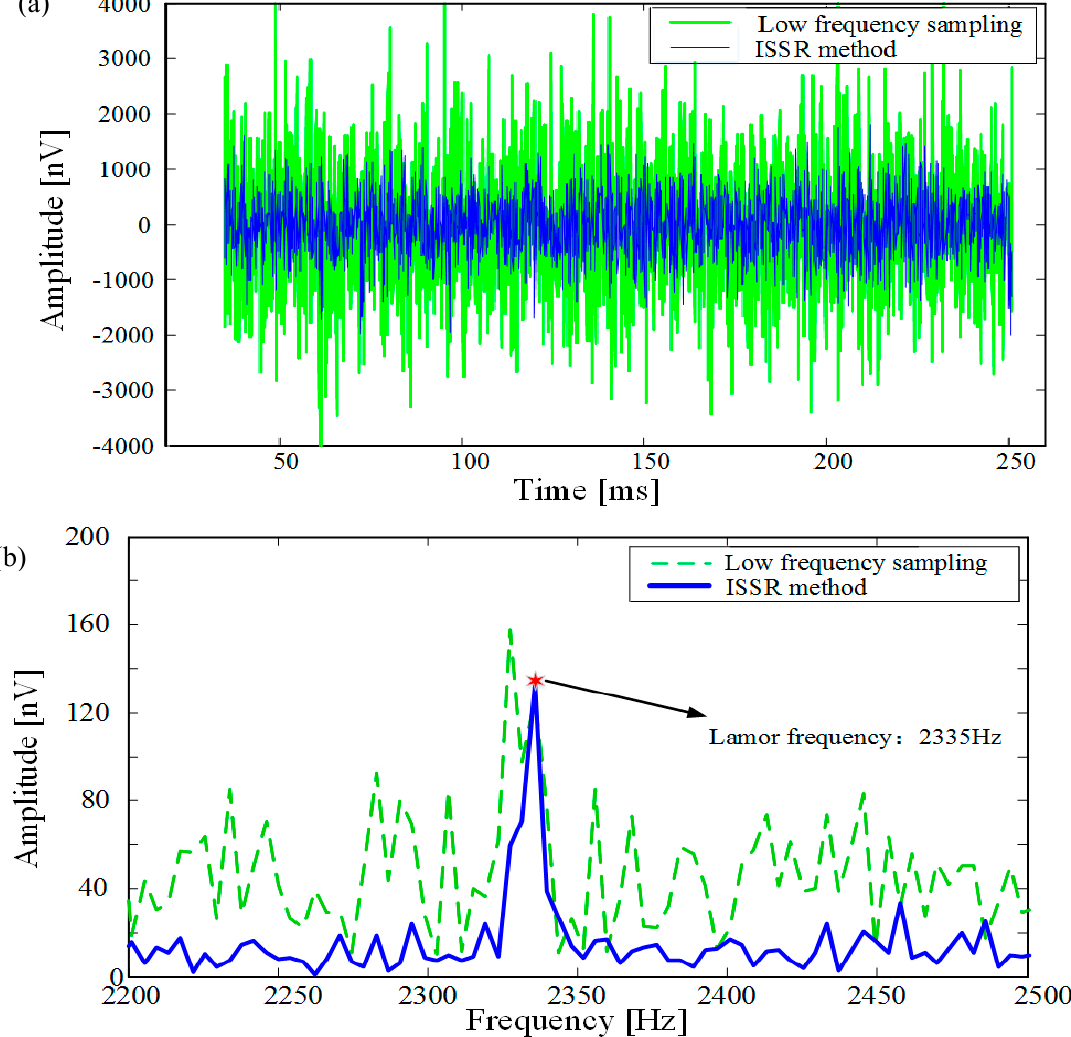
Figure 16. Comparison of low frequency sampling result and the ISSR method results. The green lines display low frequency sampling recording (its sampling frequency is 8330 Hz) and the standard deviation is 1200.80 nV. The blue lines display the data by the ISSR method (its sampling frequency is 50 kHz, f prop = 8333.3 Hz) and the standard deviation is 570.01 nV. ( a ) Comparison in time domain. ( b ) Comparison in frequency domain.